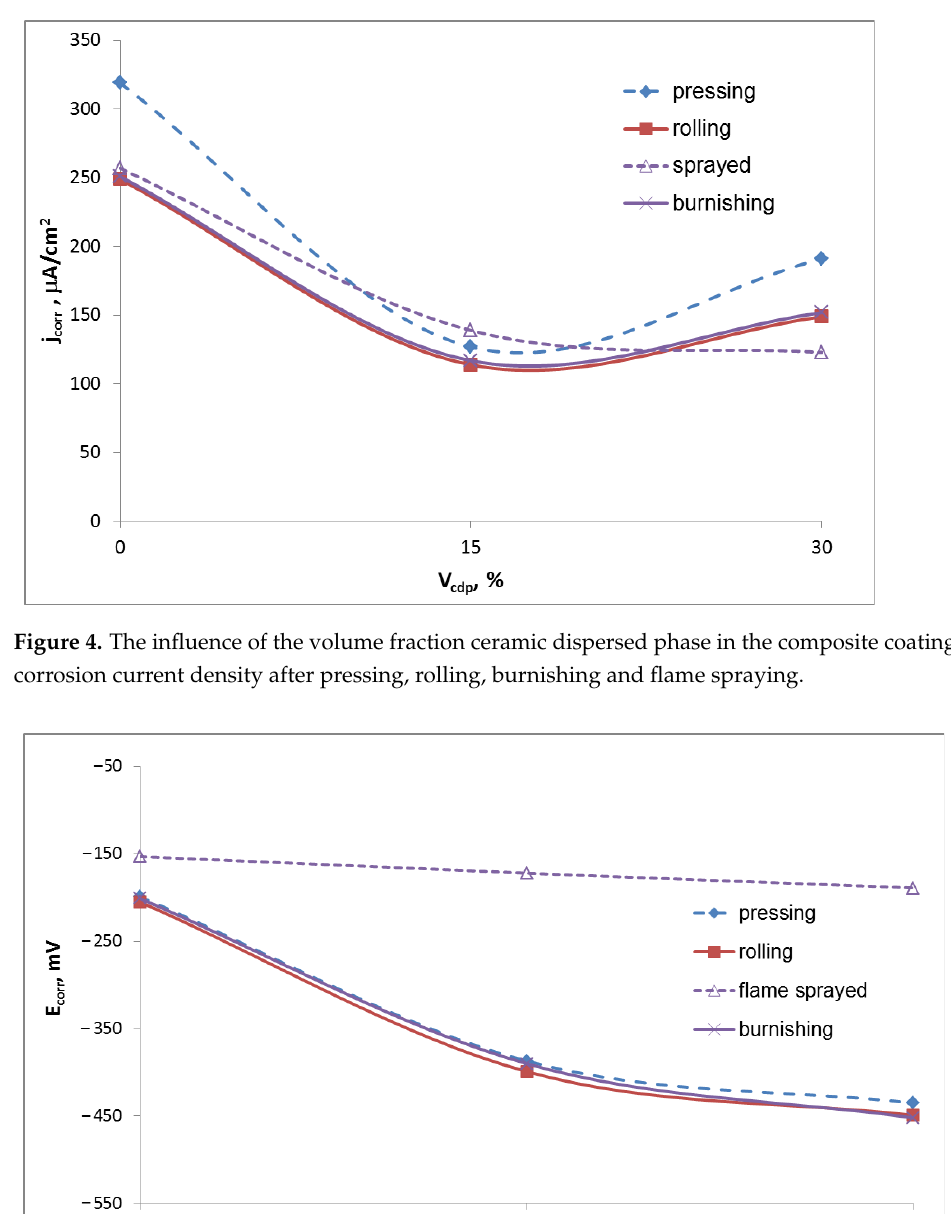
Figure 3. The microstructure for: ( a ) alloy coatings after being flame sprayed and ( b ) alloy coatings after burnishing; ( c ) alloy and ( d ) composite coatings after rolling; ( e ) alloy and ( f ) composite coatings after pressing.